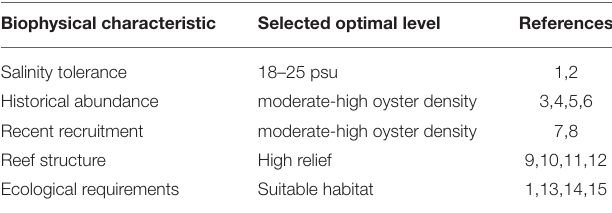
TABLE 1 | Biological characteristics and physical requirements used in the determination of reef restoration